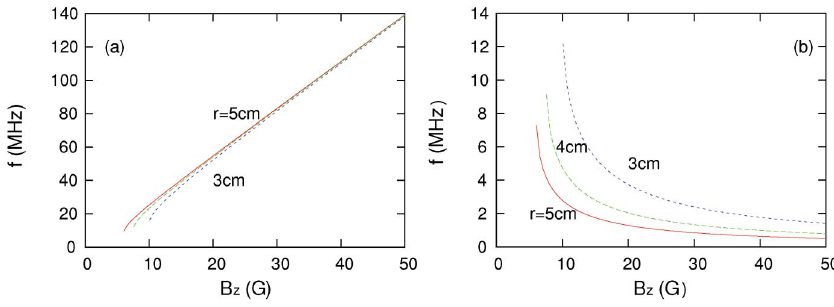
FIG. 9. (Color) Magnetron frequency as a function of B